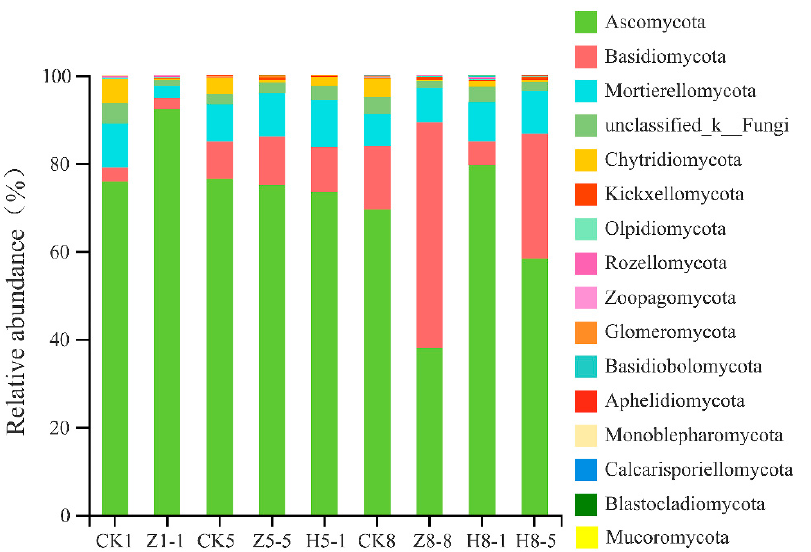
Figure 4. Community composition of fungi at the phylum level in soil in different years of growing and replanting. Note: The nomenclature for each sample is the same as that in Table 2.